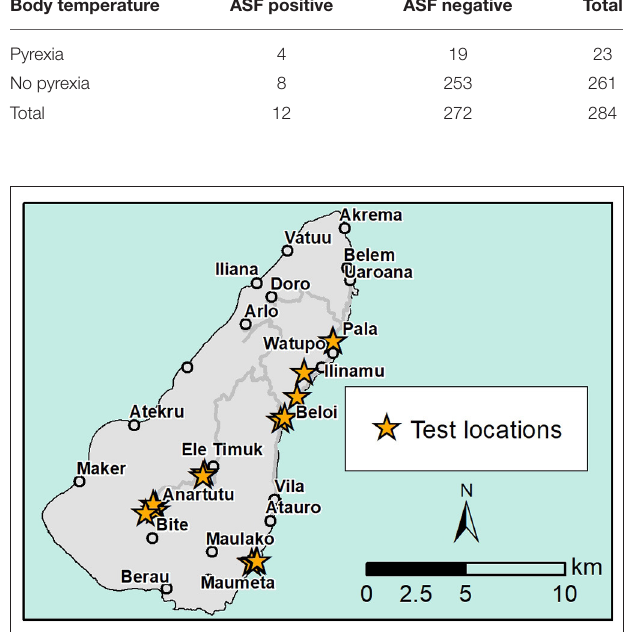
FIGURE 4 | Map showing sample results and location on Atauro